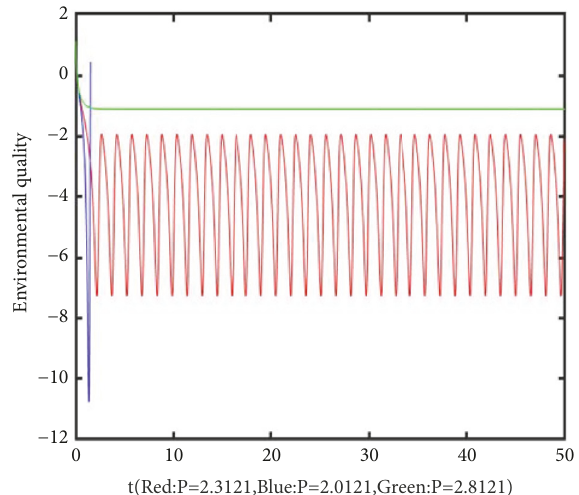
Figure 11: The identified system (1): the influence of environmental quality under the different parameters 𝑃